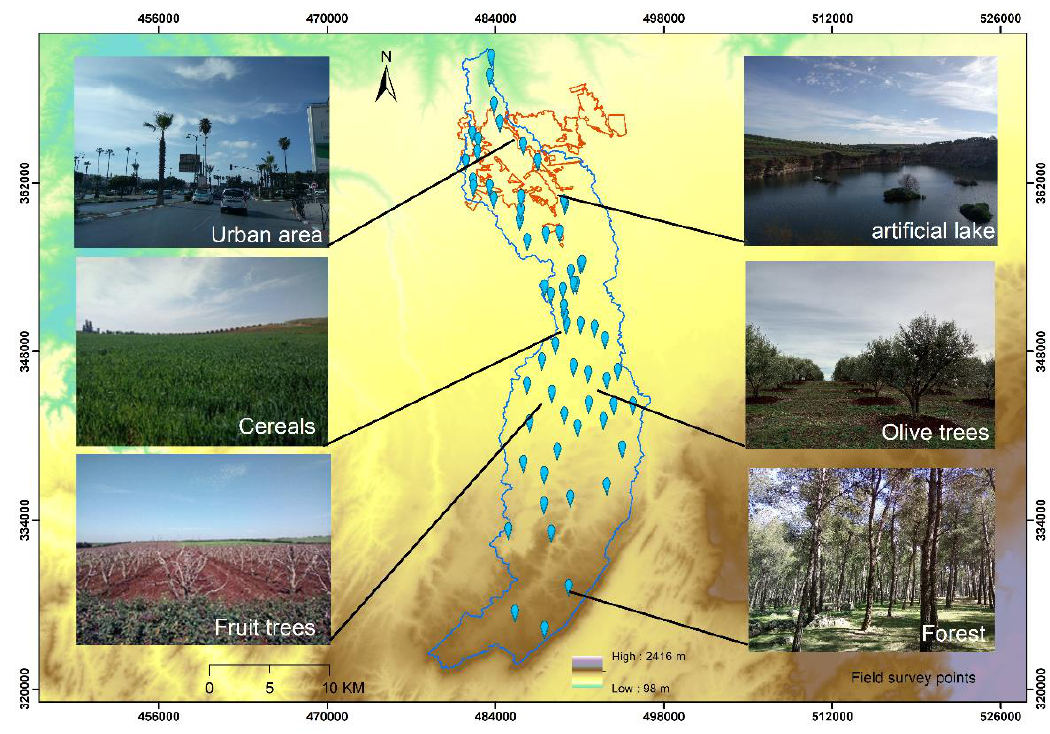
Figure 3. Field survey points.